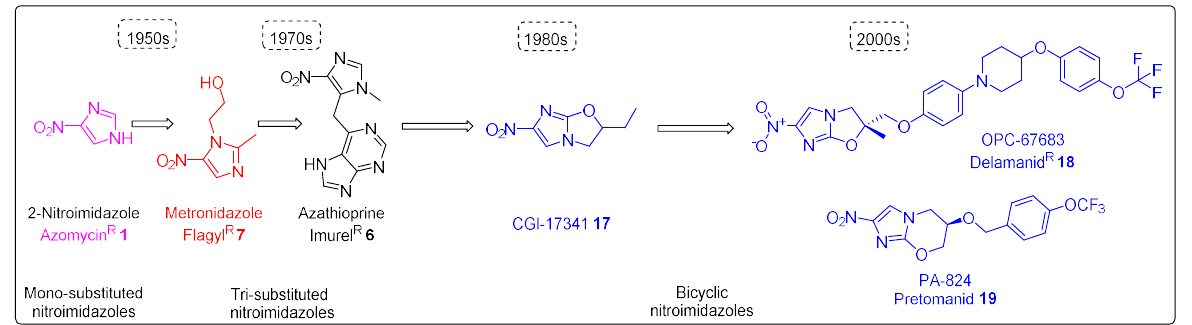
mix, Newark, NJ, USA), and Dimetridazole 13 (Emtryl ® , developed by Rhône-Poulenc, these,